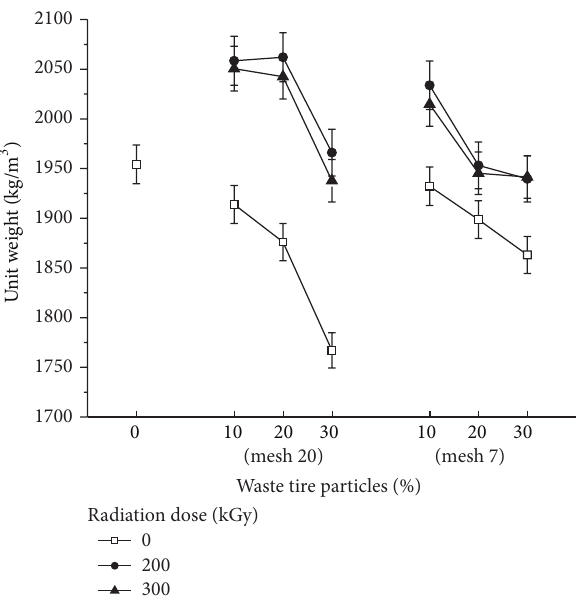
Figure1:Unitweightofconcretewithwastetireparticlesatdifferent irradiated doses.